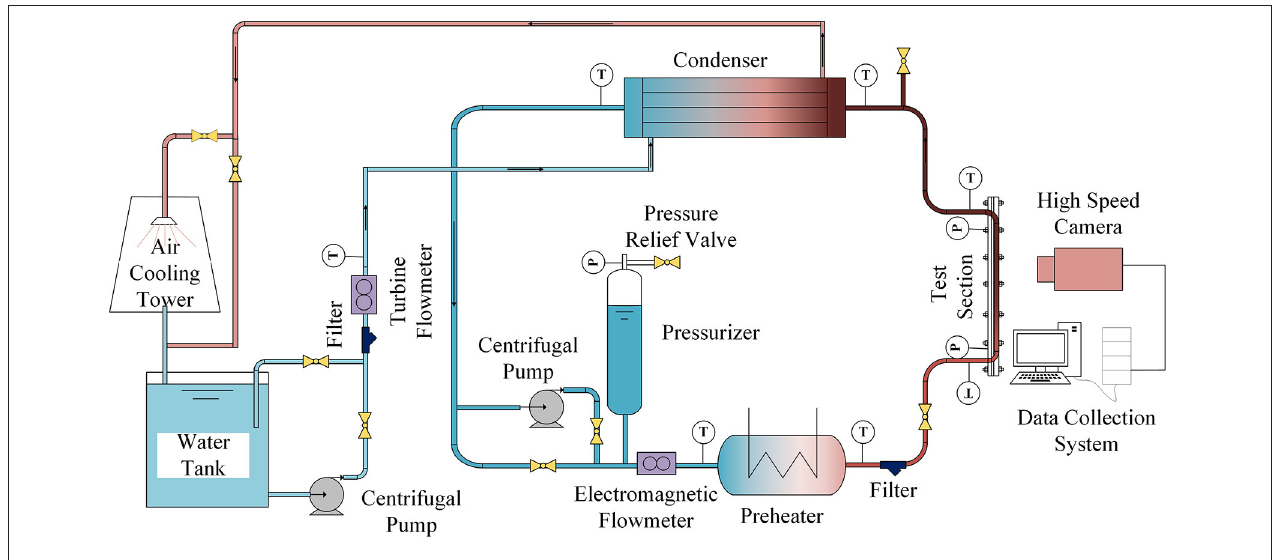
FIGURE 1 | Schematic diagram of experimental loop.